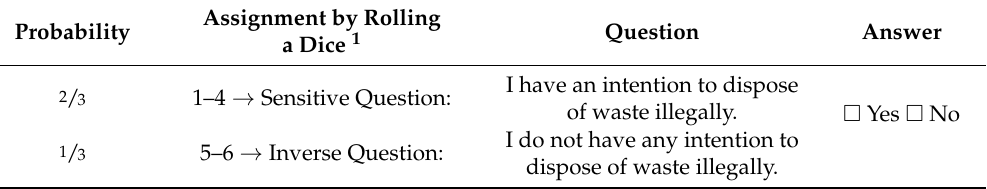
Table 1. Example of randomized response technique (RRT) application by using Warner’s method. Assignment by Rolling a Probability